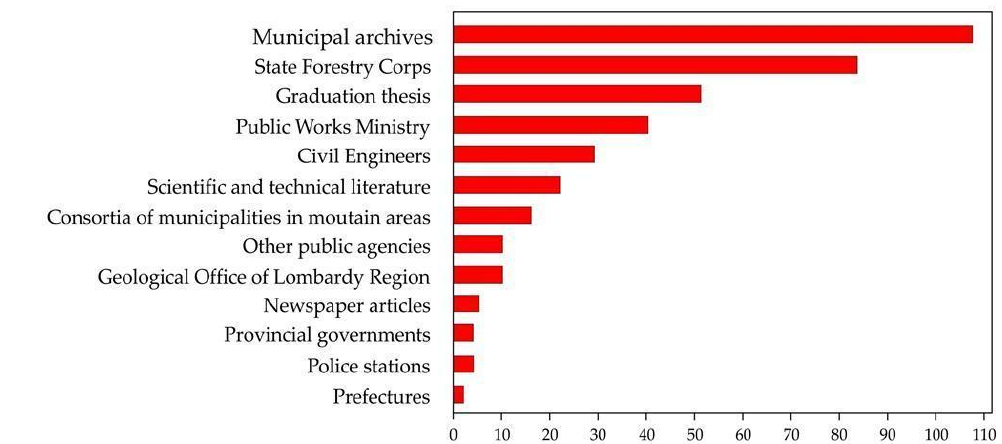
Figure 5. Example of shallow landslides and mud-debris flows triggered by intense rainfalls in the alpine and pre-alpine provinces of the Lombardy region: ( A ) view of the debris flow that occurred in Vallone di Campo (SO) in 1937; ( B ) view of the soil slips triggered by heavy rainfalls that occurred on 1 June 2002 in Malnate (VA) in the Olona Valley, close to the bridges of the motorway and railway; and ( C ) view of the Rossiga mud-debris flow that occurred in Cortenova (LC) on 27 November 2002. The red arrow indicates the maximum level reached by the debris. ( D ) View of the mud-debris flows that occurred in Brienno (CO) on 7 July 2011 that destroyed some buildings and caused severe damage to structures and infrastructures (image source: CNR-IRPI authors).